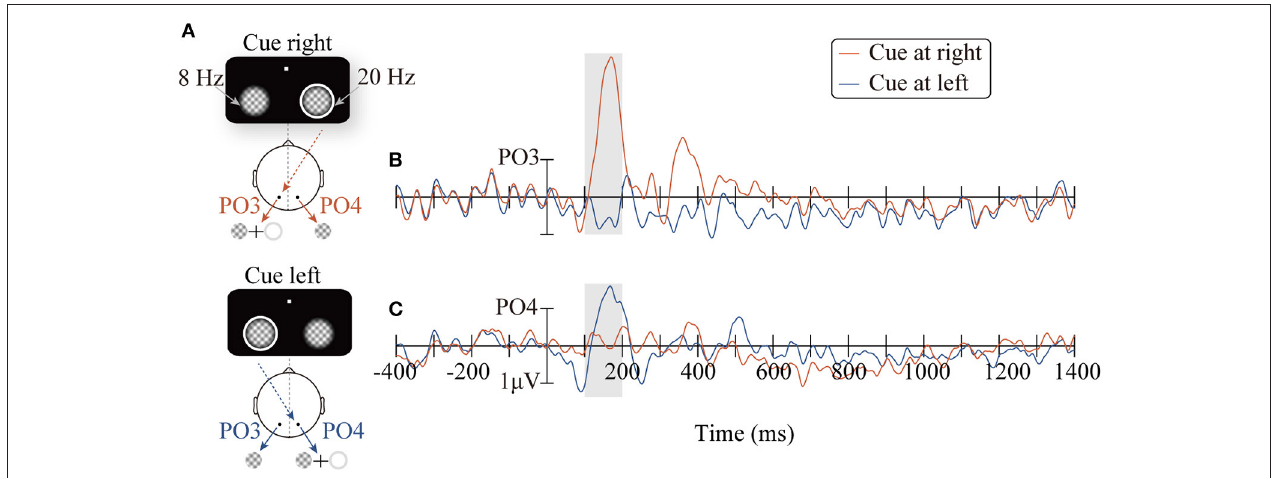
FIGURE 2 | The diagrams of the two conditions: CR and CL for presenting the peripheral cue at the right (red line) and the left location (blue line), respectively (A) . ERPs waveforms time-locked to the peripheral cue at the PO3/PO4 electrodes (B,C) .